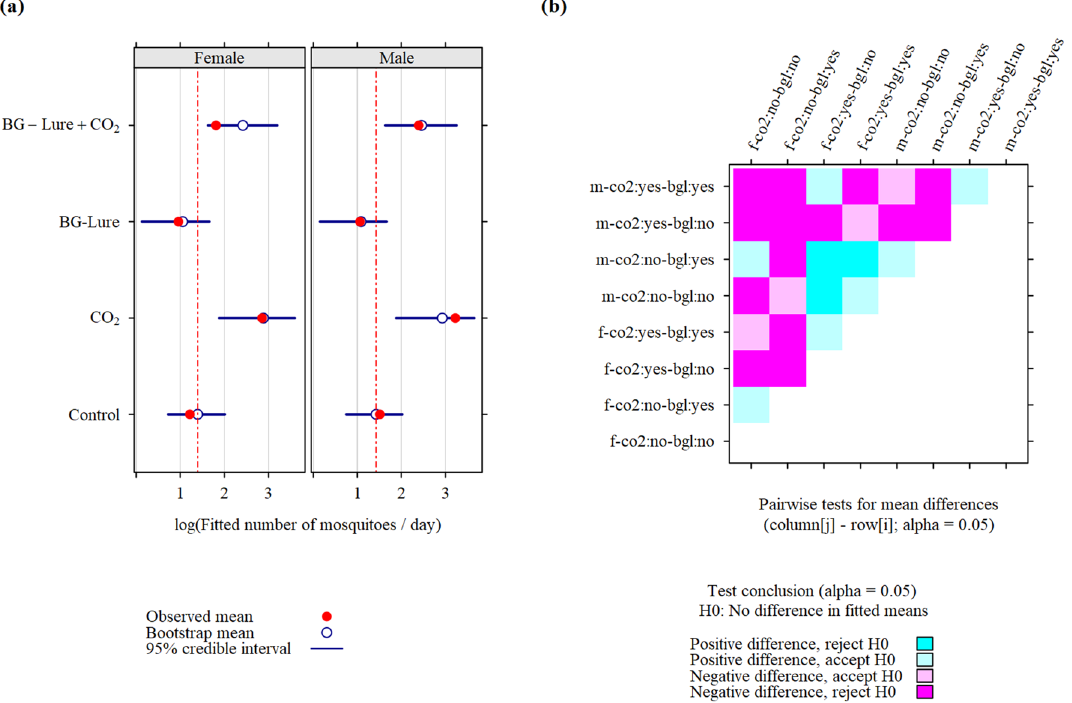
Figure 3. Fitted apparent density ( a ) and corresponding pairwise tests ( b ) for differences in fitted means for adult Aedes aegypti mosquitoes collected in 2020 (89 trapping sessions) during a field experiment in La Reunion. Coding scheme for row and column labels: sex (m/f)—CO2 (co2:yes/co2:no)—BG-Lure (bgl:yes/bgl:no).